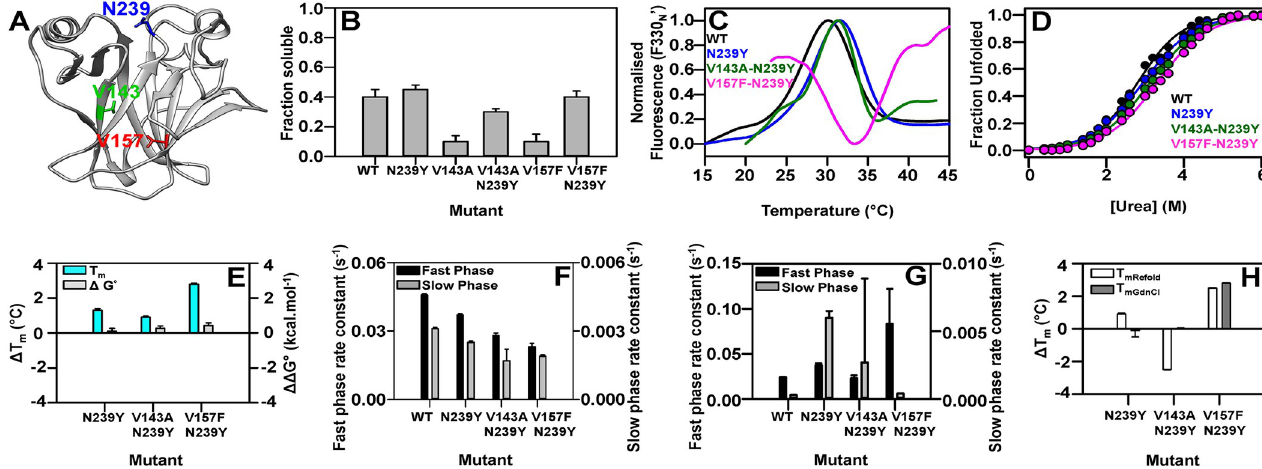
Fig 4. Characterisation of an N239Y global suppressor in DNA Binding Domain of p53. (A) Inactive mutants and distal suppressor N239Y mapped onto the crystal structure of p53-DBD (PDB ID 2OCJ [77]). The p53-DBD is shown in ribbon with the suppressor N239Y, mapped on an exposed region, while the inactive mutants V143A and V157F are present in the core of the protein. (B) Influence of N239Y substitution on p53-DBD solubility levels. (C-D) Thermal unfolding profiles and equilibrium Urea denaturation profiles respectively of purified WT and p53-DBD mutants. (E) The difference in thermal stability, Δ T m ð D T ¼ T (cid:0) T Þ of native proteins (in cyan), and thermodynamic stability assayed by chemical denaturation, ΔΔ G˚ ð DD G � ¼ D G � m m Mutant m WT grey) of the different p53-DBD mutants. (F-G) The observed rate constants of the fast phase (black) and slow phase (grey) of unfolding in 4.4 M Urea (F) and of refolding in 2 M Urea (G) of different mutants are represented. (H) The difference in thermal stability ð D T (white) and refolded proteins in 0.5 M Urea (grey). The error bars wherever shown represent the standard deviation from two independent experiments, each performed in duplicates.